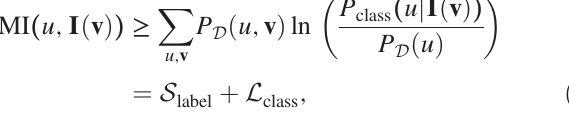
L to the label þ class P ˜ P e − E ð v ; h Þ Þ of generated digits by constrained ð v Þ ¼ ln ð h ˜ P ð v Þ